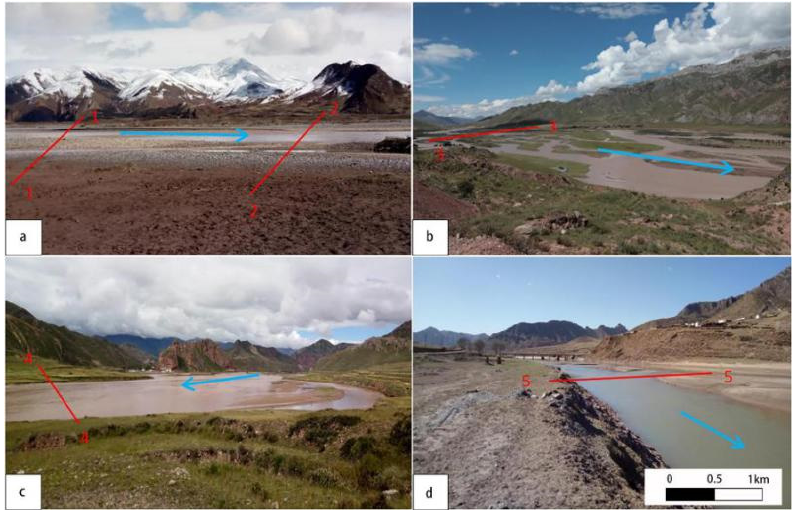
Figure 6. Photographs of field geomorphology and river flow direction for the sampled river sections along the Lancang River source. ( a ) shows Section 1 and Section 2; ( b ) shows; ( c ) shows Section 4; ( d ) shows Section 5. The direction of the arrow is the direction of the river